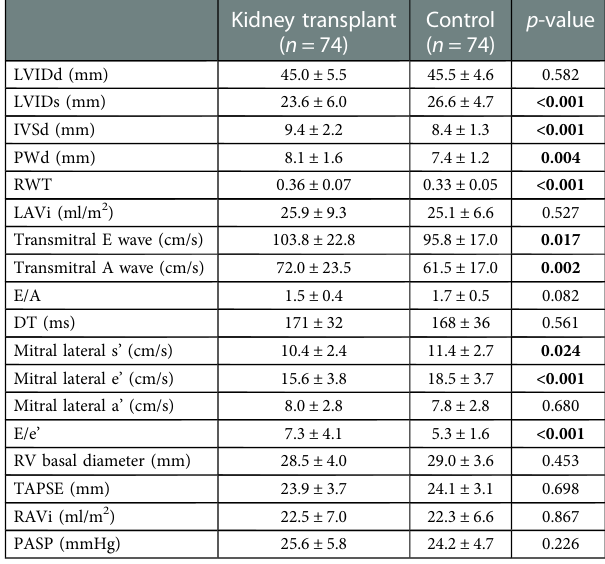
TABLE 1 Baseline characteristics of the kidney transplant and the control groups.